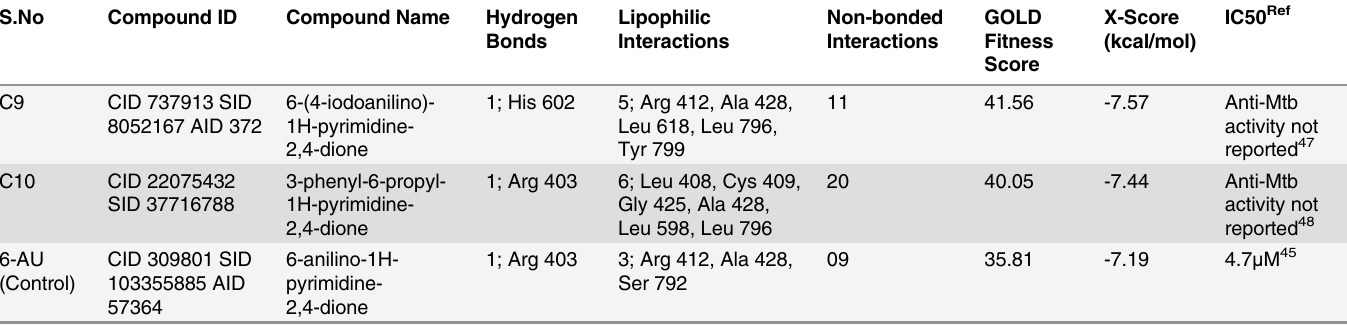
Table 2. Molecular Docking Results and Interaction Analysis for Identified 6-AU and its analogous against Mtb DnaE2.